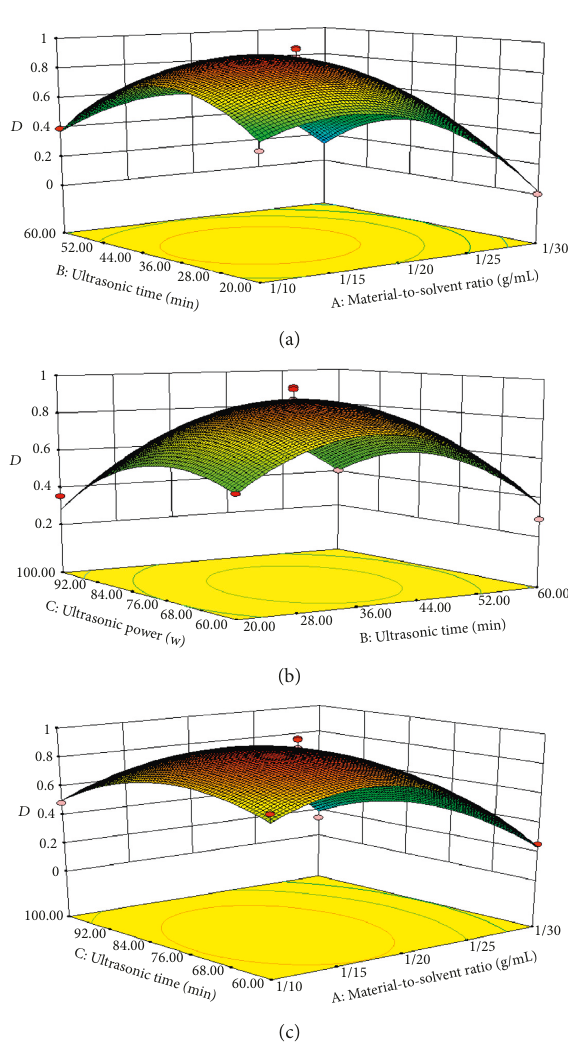
Figure 2: (a) 3D graphic surface optimization of D versus ultra- sonic time and material-to-solvent ratio; (b) 3D graphic surface optimization of D versus ultrasonic power and ultrasonic time;